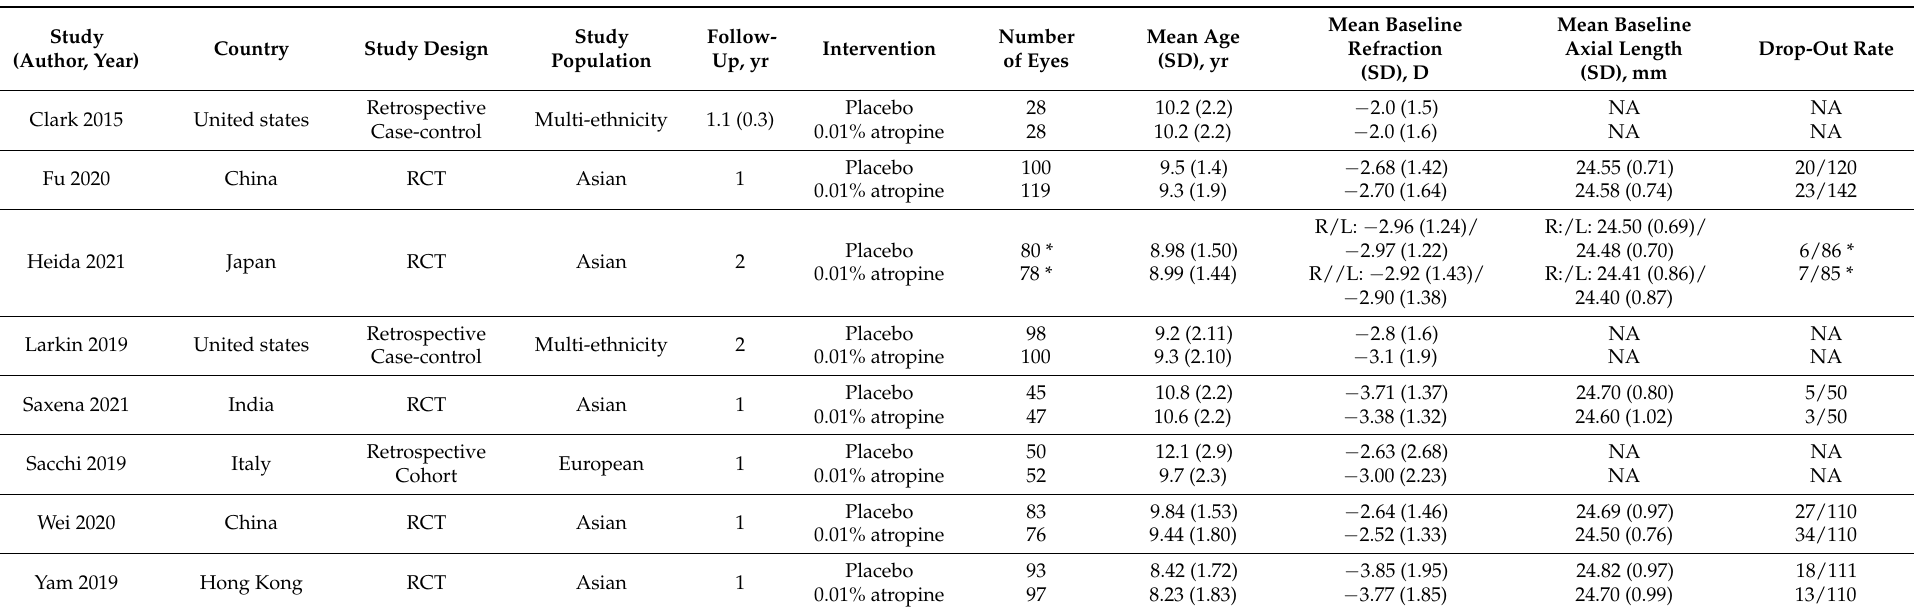
Table 1. Characteristics of studies included in the